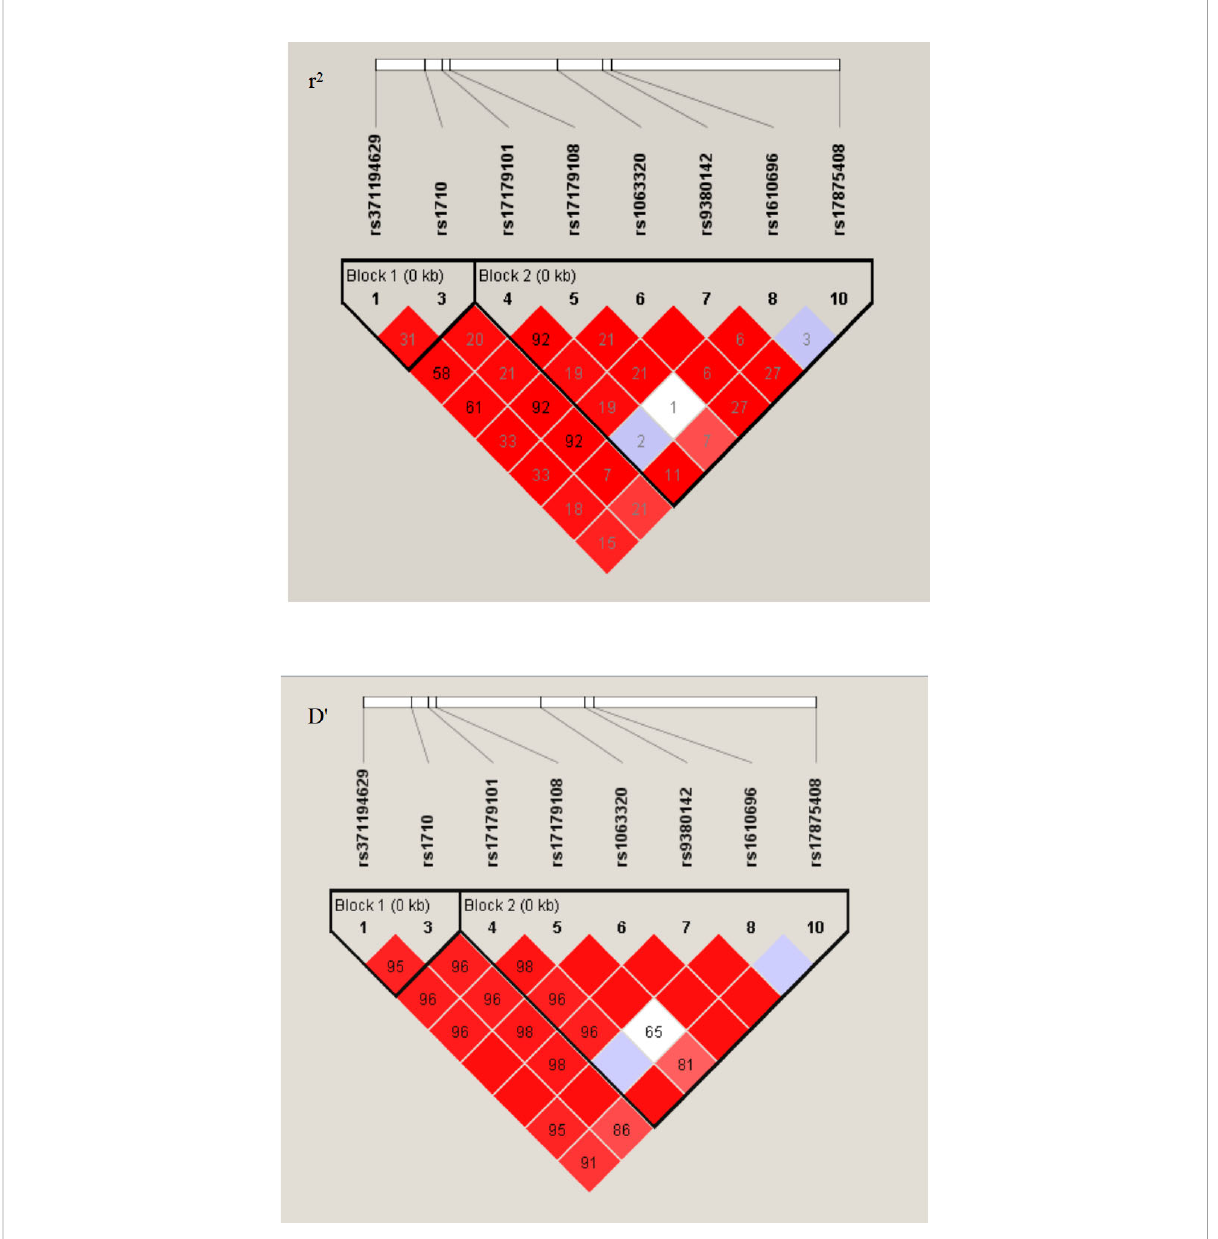
FIGURE 1 LD patterns between eight pairs polymorphic sites at the 3 ’ UTR region of HLA-G gene. The image was generated in the Haploview 4.2. D ’ and r 2 , pairwise correlation between polymorphic sites. Areas in red indicated strong LD (r 2 >0.8), shades of pink indicated moderate LD, and white indicates low LD. The r 2 values (×100) for the marker pairs are listed in the corresponding